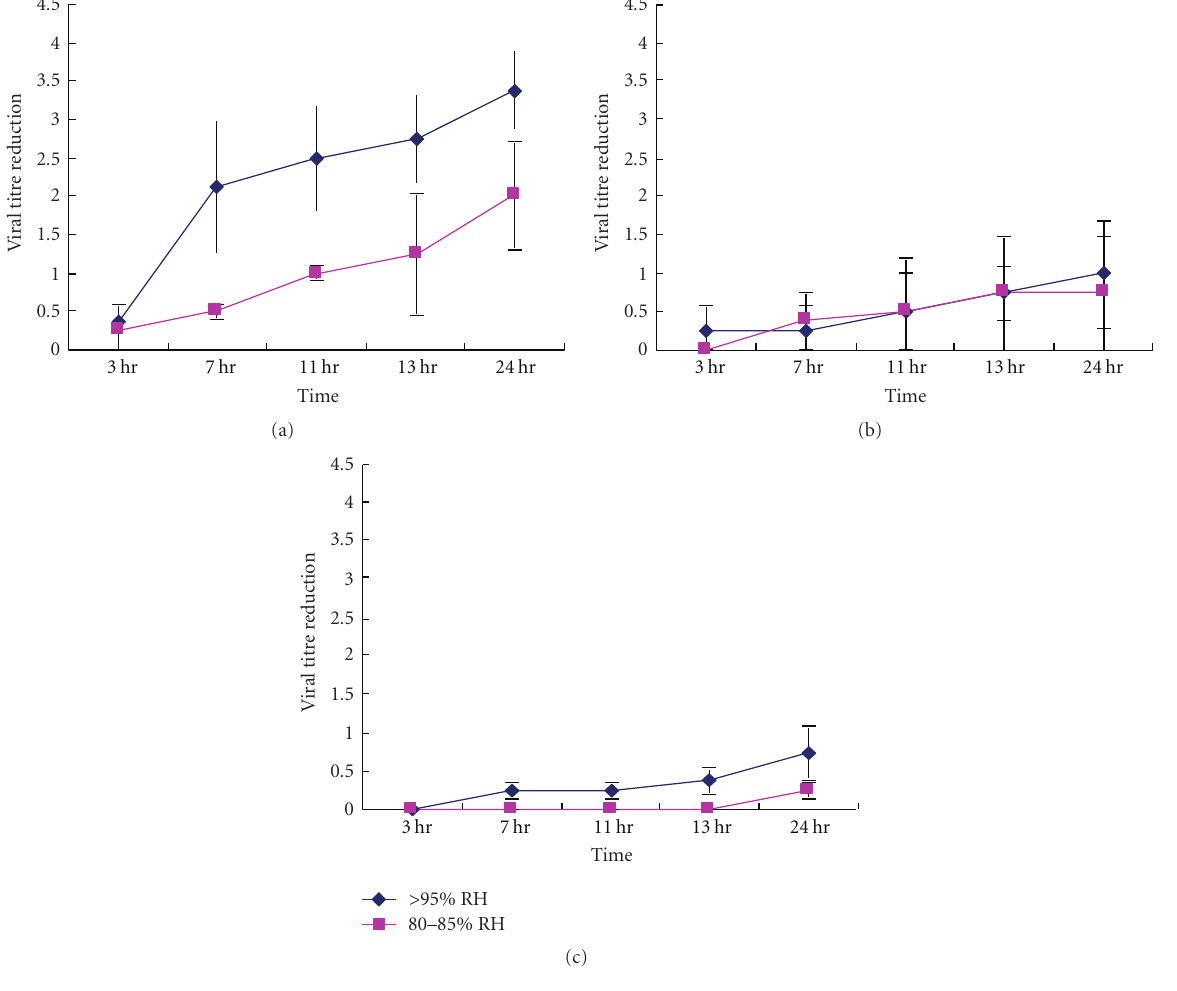
Figure 3: Infectivity of SARS Coronavirus (starting titre 10 5 /10 μ L) at di ff erent relative humidity at (a) 38 ◦ C, (b) 33 ◦ C, and (c) 28 ◦